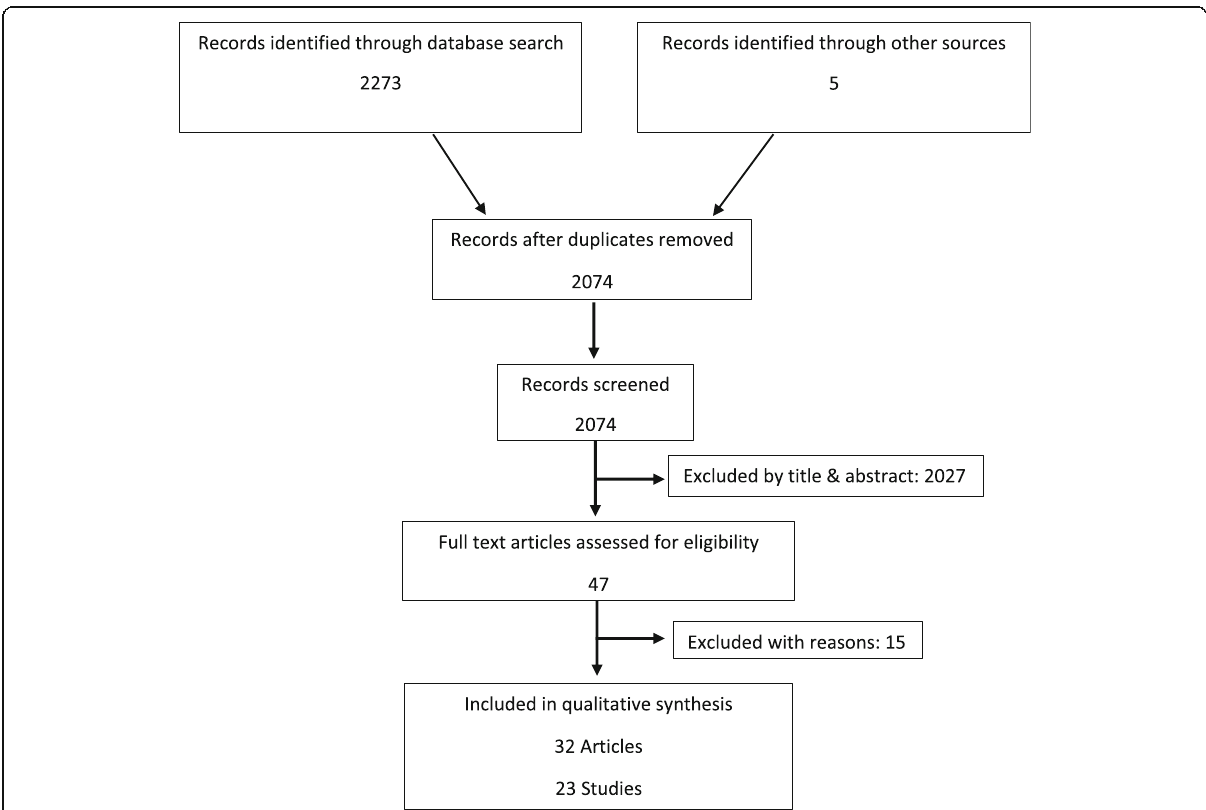
Fig. 1 Flow diagram of study selection